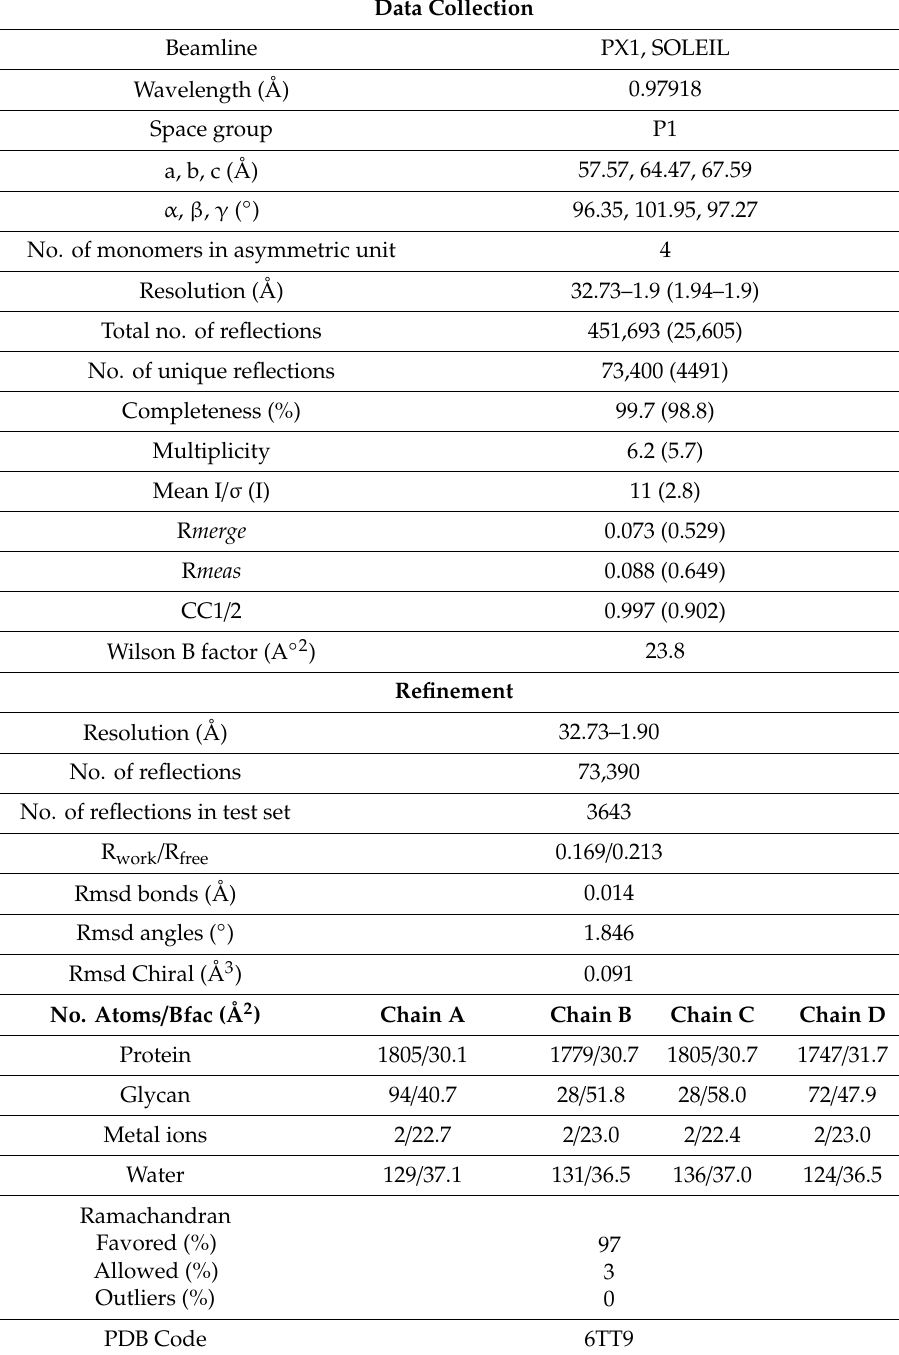
Table 1. Data collection and refinement